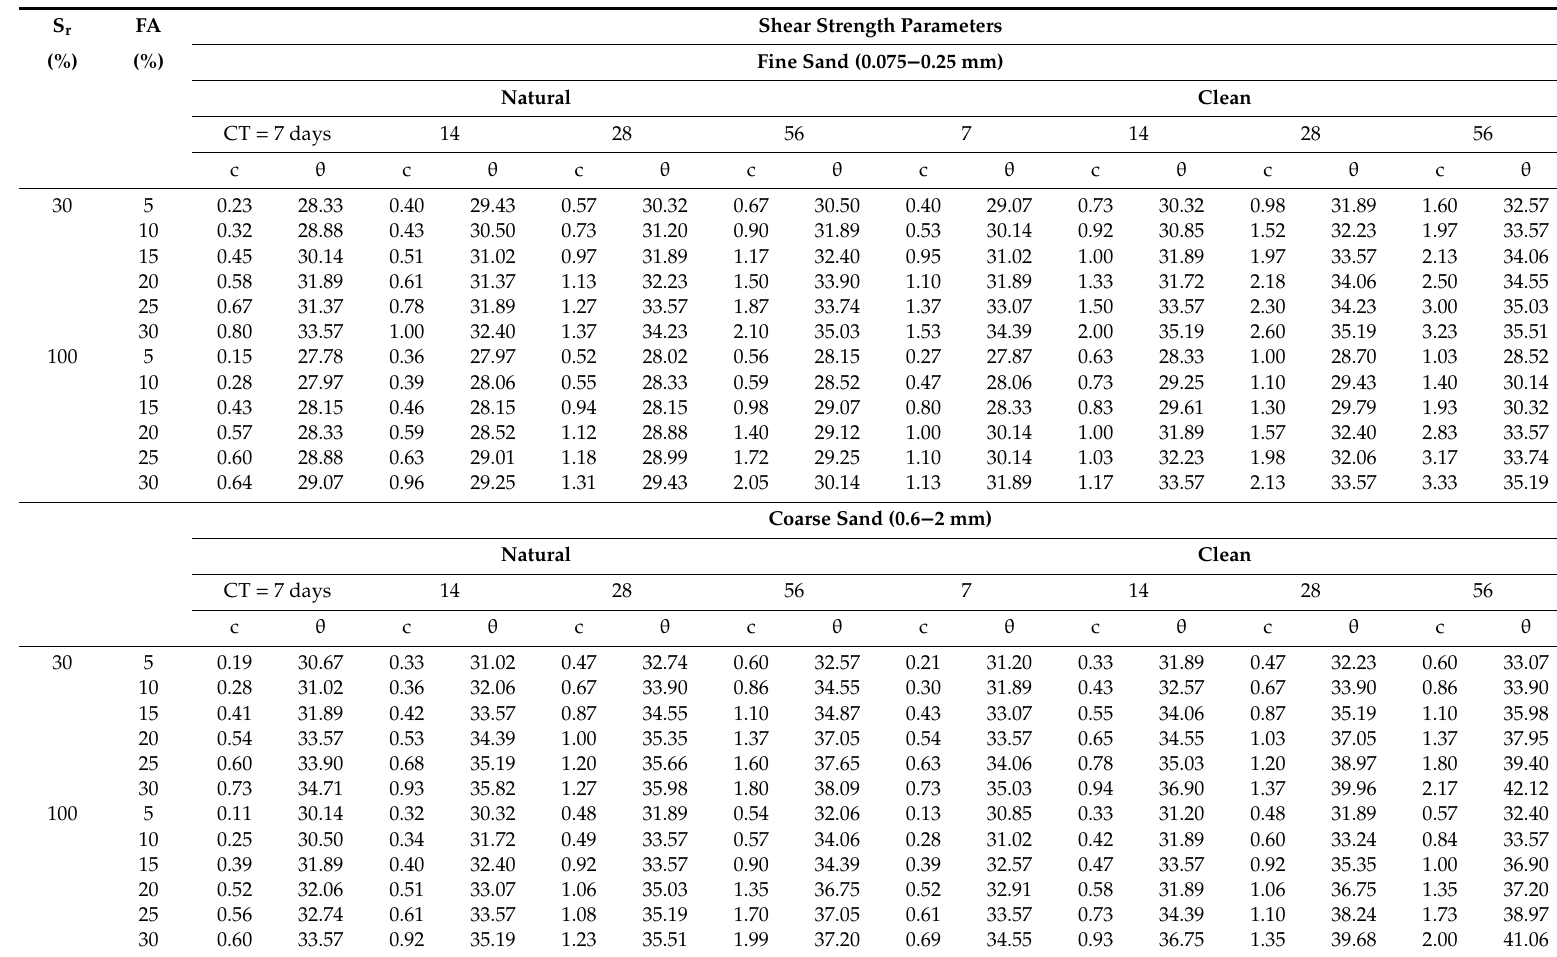
Table 6. Shear strength parameters of sand stabilized with fly